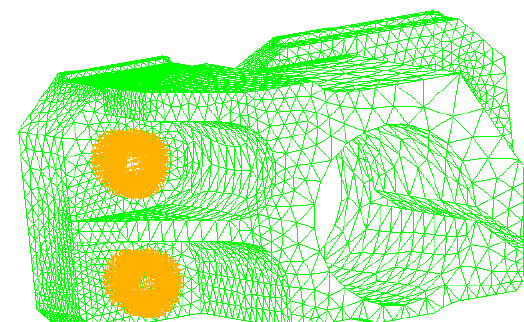
Figure 5. The Geometry and its FEM of horn holder’s